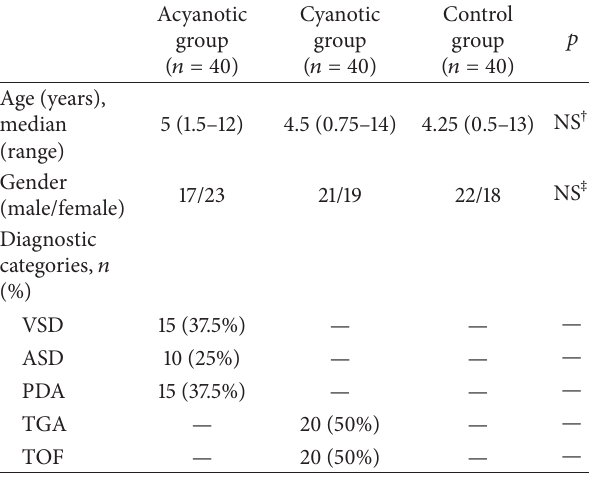
Table 1: Demographic and clinical criteria of study population.